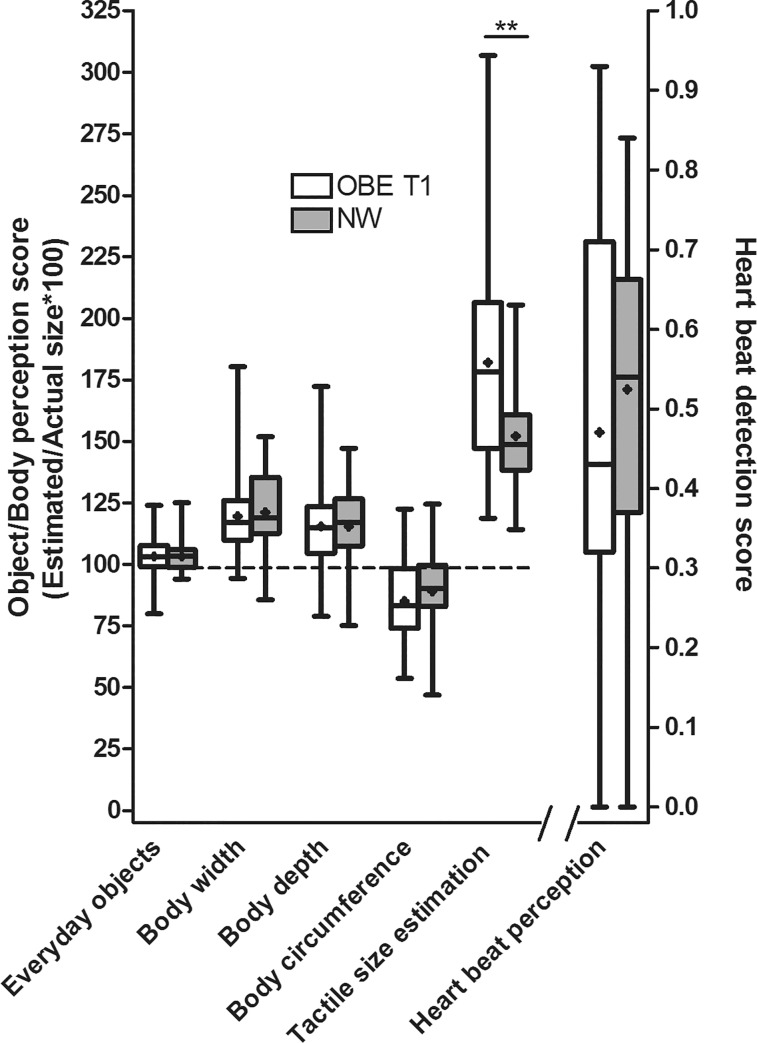
Perception Scores of body perception in obese children (OBE) before weight loss (T1) in comparison to normal-weight children (NW).The perception scores of everyday objects, body width, body depth, body circumference, tactile size estimation and heartbeat detection are displayed as box-whiskers with a cross, the latter depicting the mean. Except for the heartbeat detection score, values below 100 indicate an underestimation and values above 100 indicate an overestimation in terms of percent of the actual size. For the heartbeat detection, a score of 1 indicates absolute accuracy of heartbeat detection and the minimum score of 0 indicates that no heartbeat was perceived. The mean±standard deviation of the perception scores were as follows: Everyday objects–OBE: 103±08, NW: 103±07; Body width–OBE: 120±15, NW: 121±17; Body depth–OBE 115±20, NW: 115±17; Body circumference–OBE: 85±16, NW: 89±16; Tactile size estimation–OBE: 182±41, NW: 152±25; Heartbeat detection–OBE: 0.47±0.26, NW: 0.52±0.20. Due to multiple testing the p-values were false discovery rate (FDR)-adjusted. FDR values <0.05 were considered as statistically significant. ** indicates FDR<0.01.